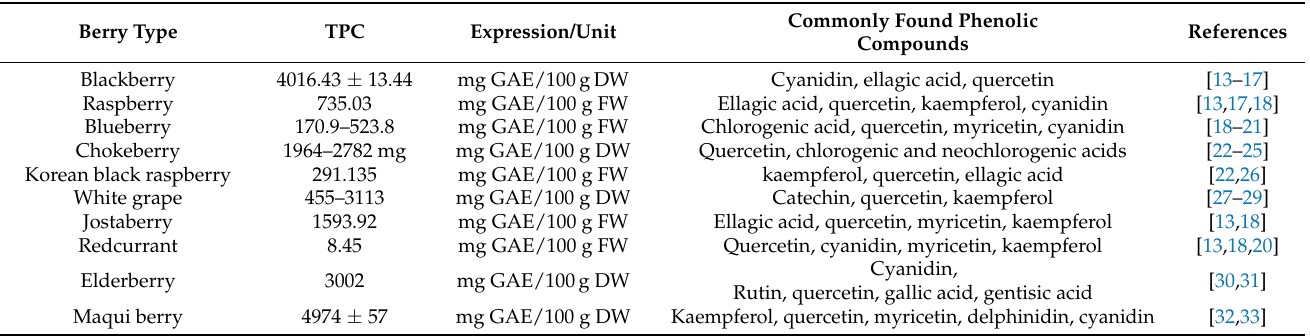
Table 1. Commonly studied berries, their phenolic compounds, and total phenolic contents. Berry